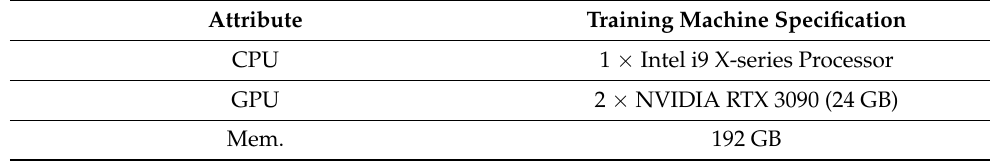
Table 4. Training machine specification.